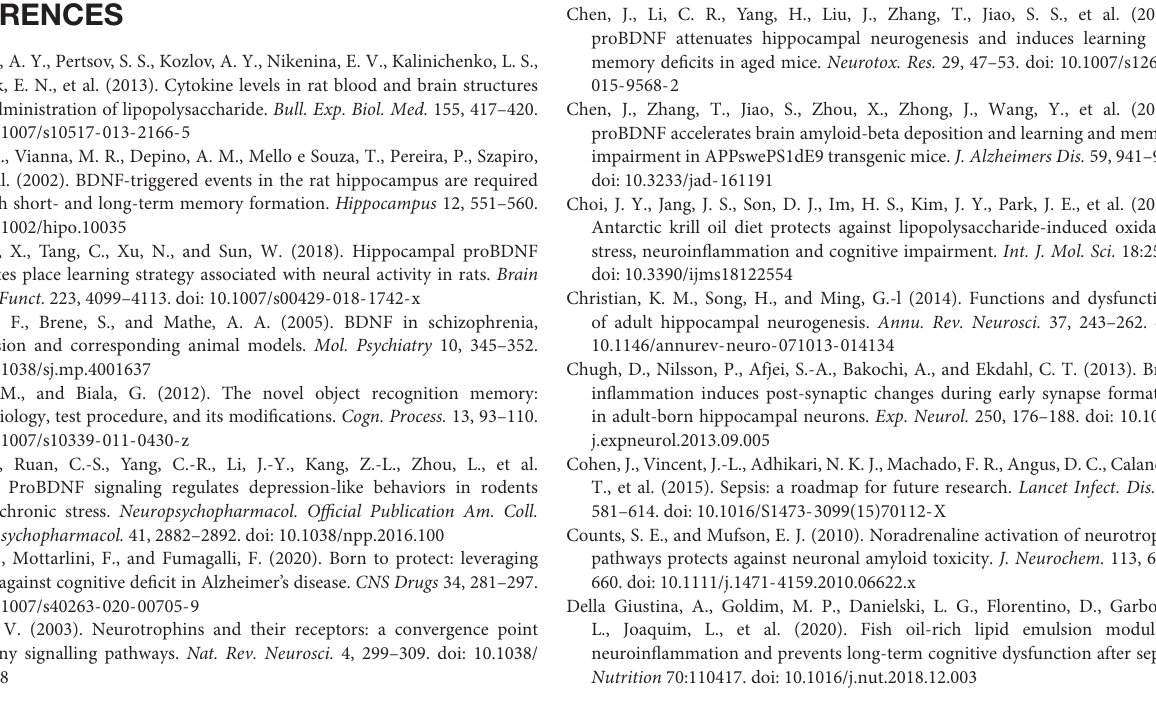
Supplementary Figure 1 | mAb-proB has no impact on the expression of BDNF, TrkB, and sortilin in the hippocampus of sepsis-associated encephalopathy mice. The expression levels of BDNF (A) , TrkB (B) , and sortilin (C) in the hippocampus tissue were measured by RT-qPCR ( n = 6/group). Data are expressed as mean ±